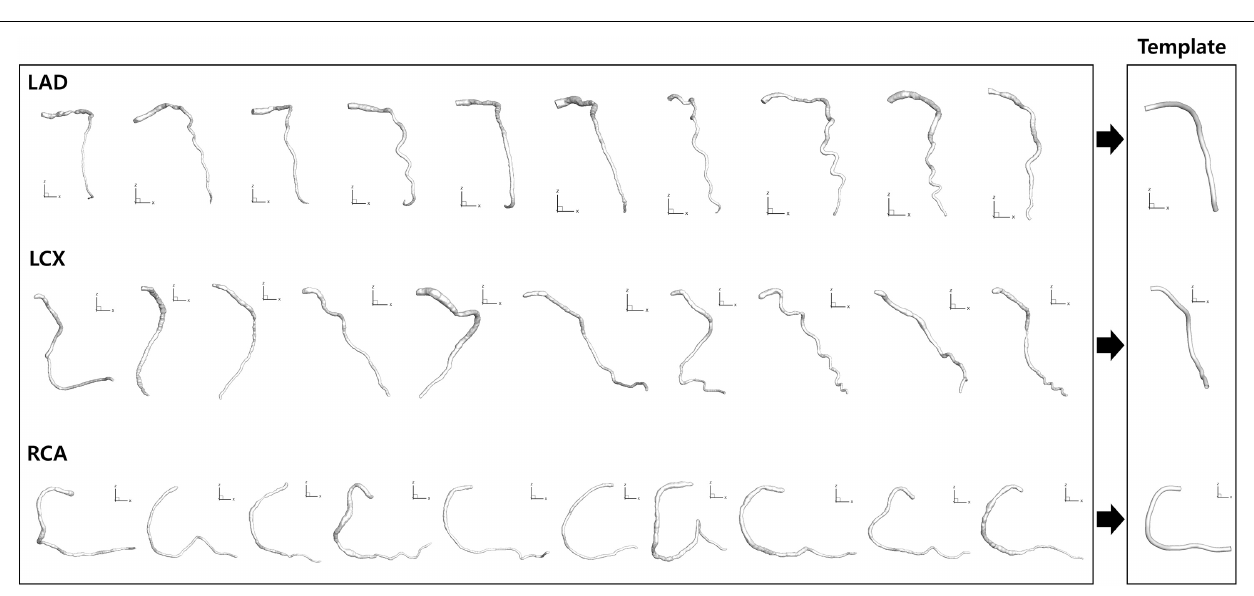
FIGURE 3 | Template model generation. Ten models for each CA reconstructed from a previous study (Lee et al., 2016b) were averaged to generate template